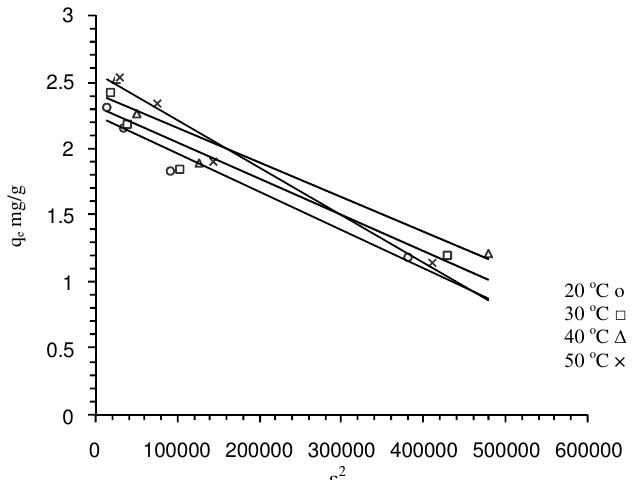
Figure 9 . D-R isotherm for the adsorption of Cr(VI) onto